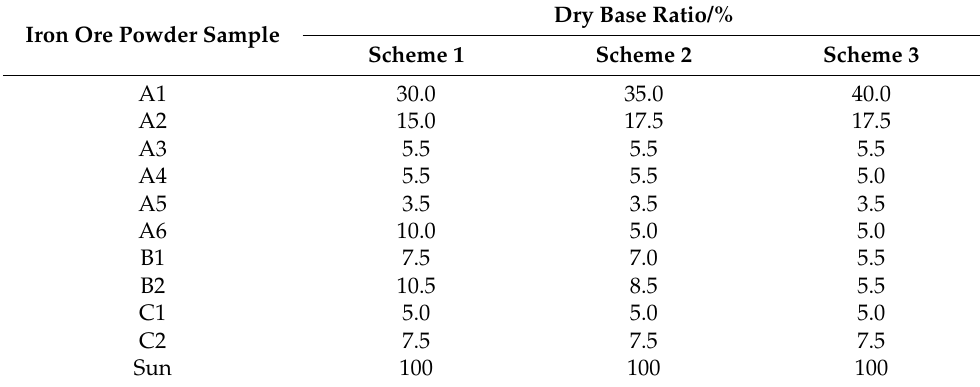
Table 7. Ore-blending scheme.